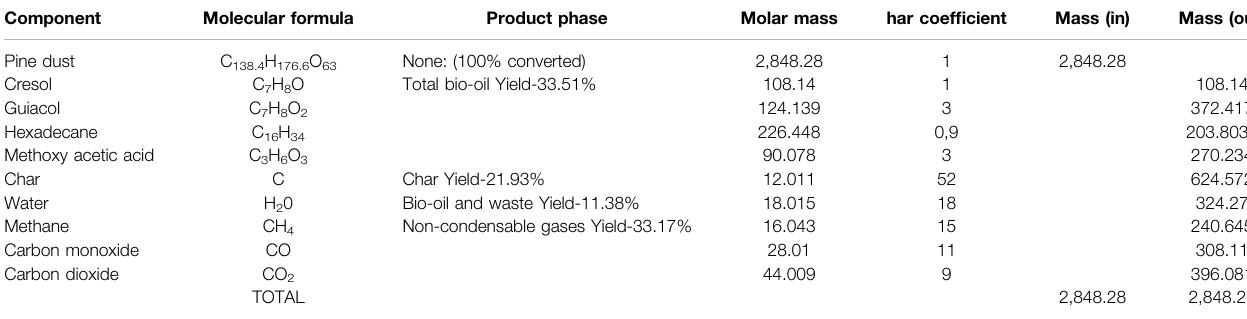
TABLE 2 | The Excel stoichiometric mass balance.